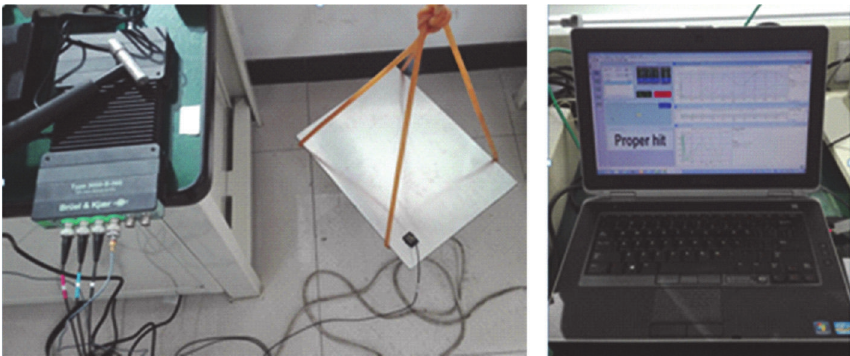
Figure 5: The specimen and test system.